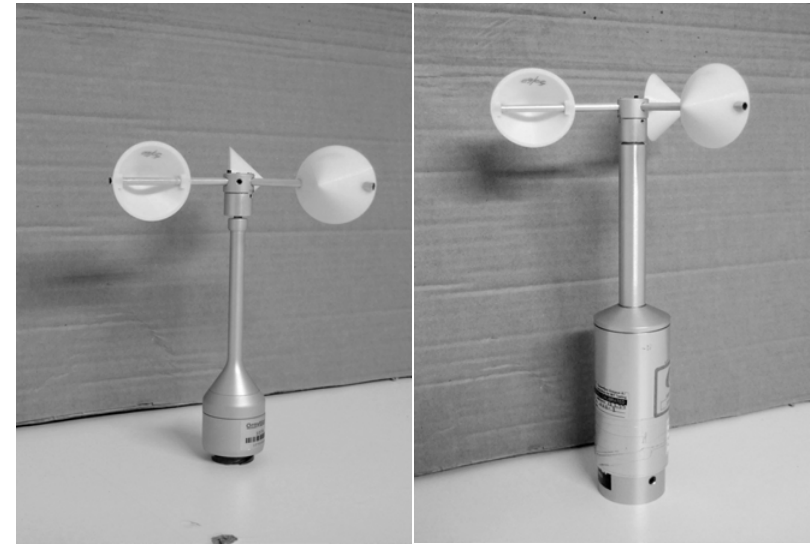
Figure 5. Ornytion 107A ( left ) and Climatronics 100075 ( right ) anemometers, both with 50/60 rotor (see in Table 1 the characteristics of each rotor tested).